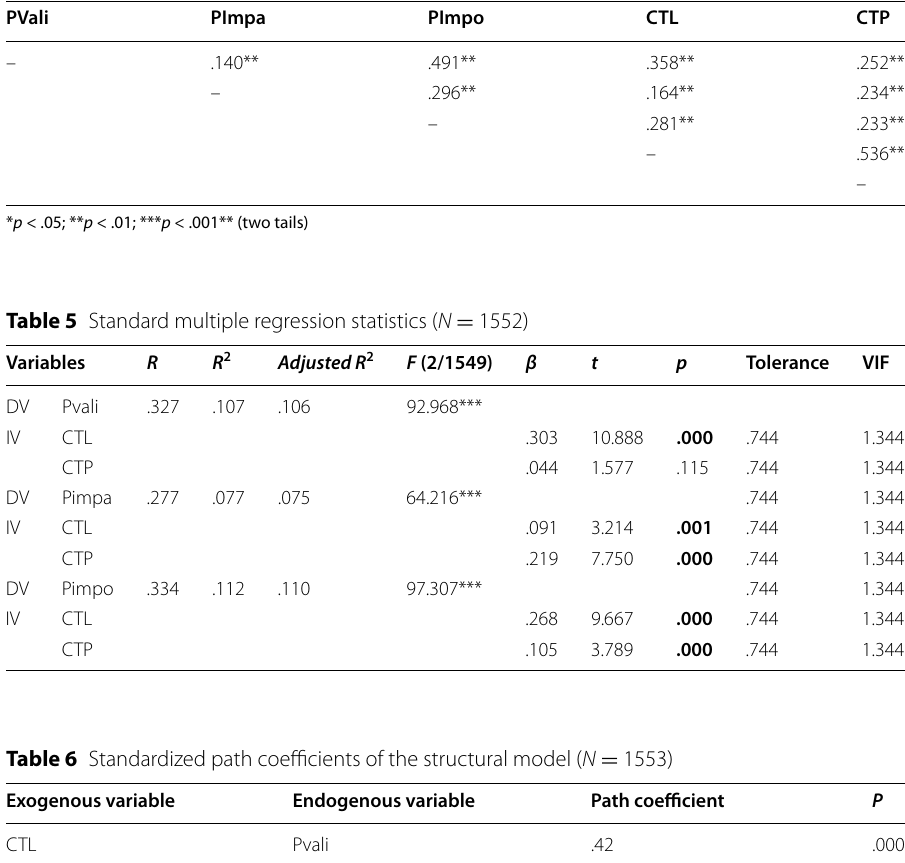
Table 4 Correlation analysis of the examined variables ( N